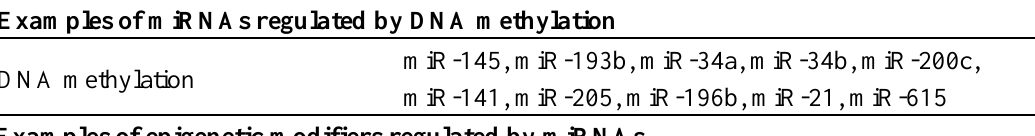
Table 1. Interaction of miRNA and epigenetic